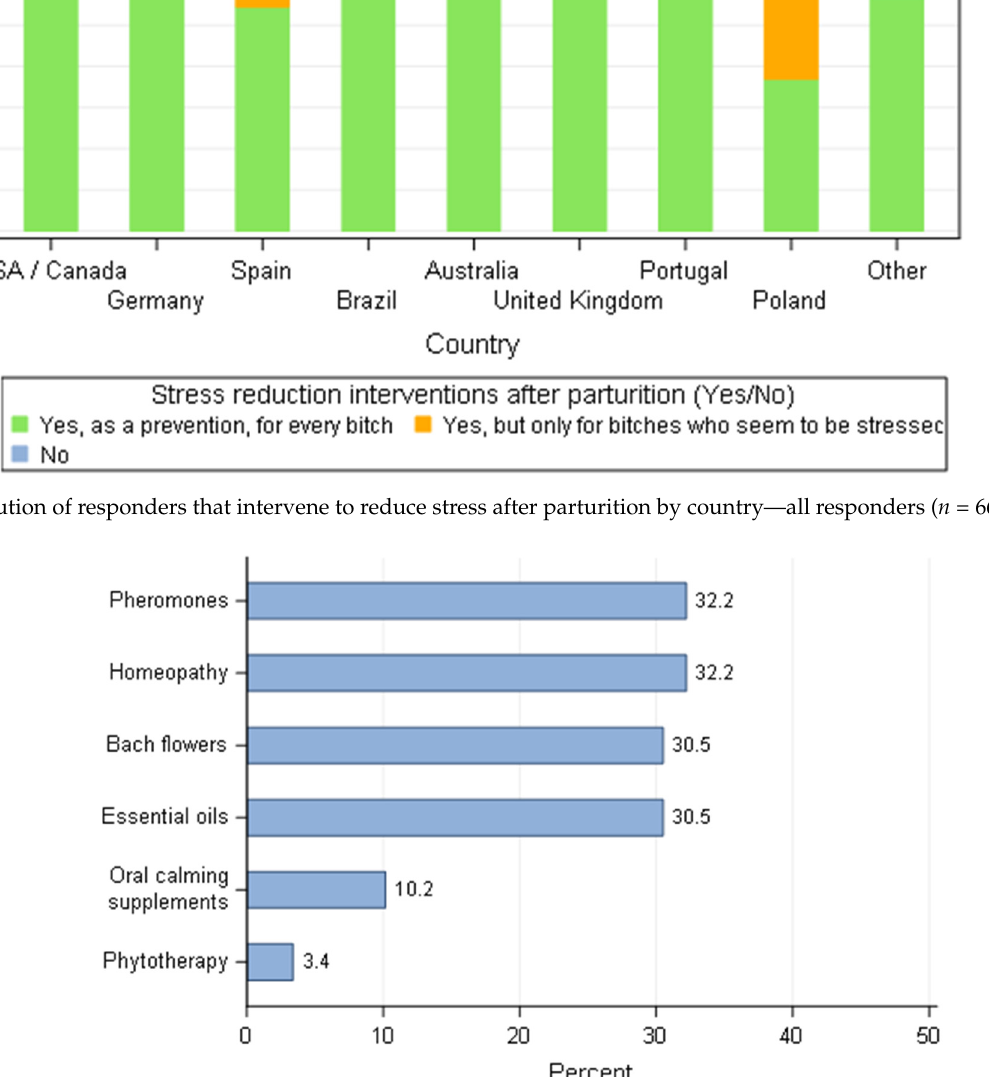
Table 2. Inappropriate maternal behaviour according to parity based on different countries ( n = 668).